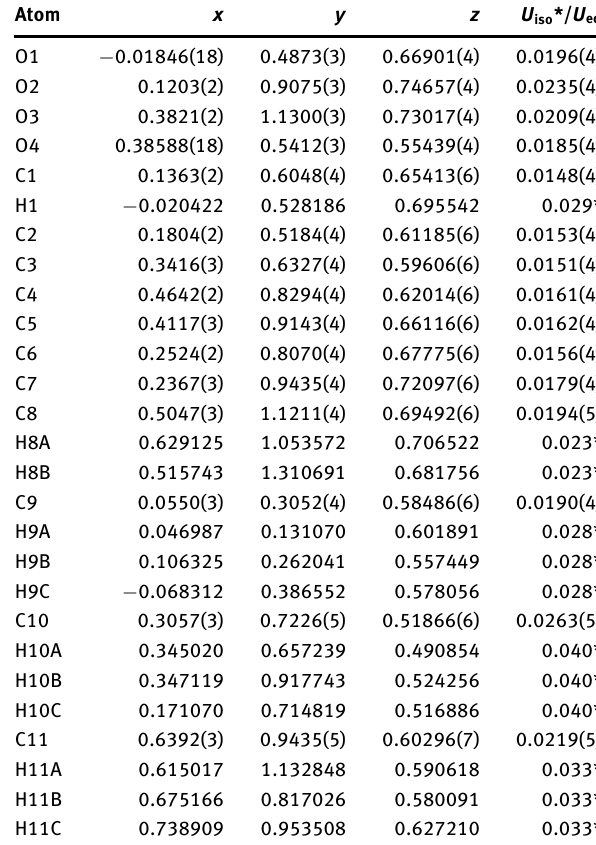
Table 2: Fractional atomic coordinates and isotropic or equivalent isotropic displacement parameters (Å 2